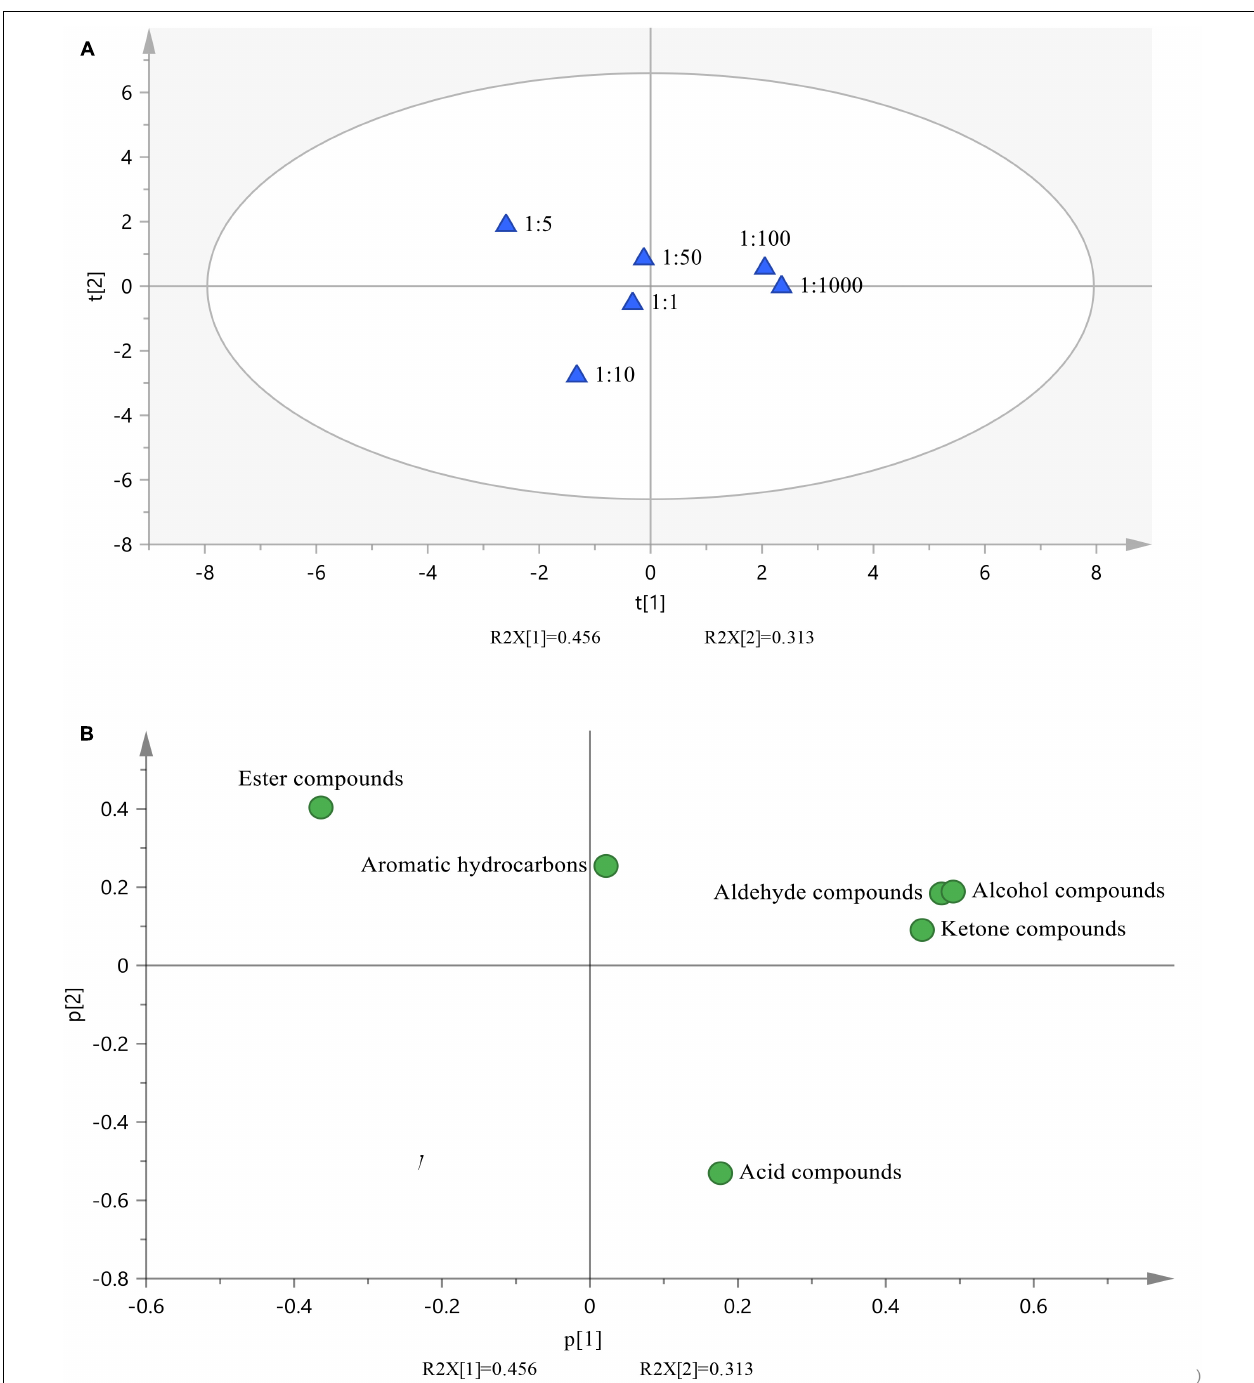
FIGURE 1 | Principal component analysis. (A) Scatter plot of the component scores for milk fermented with six different ratios of probiotic strains. (B) Scatter plot of the loadings for six classes of volatile compounds.